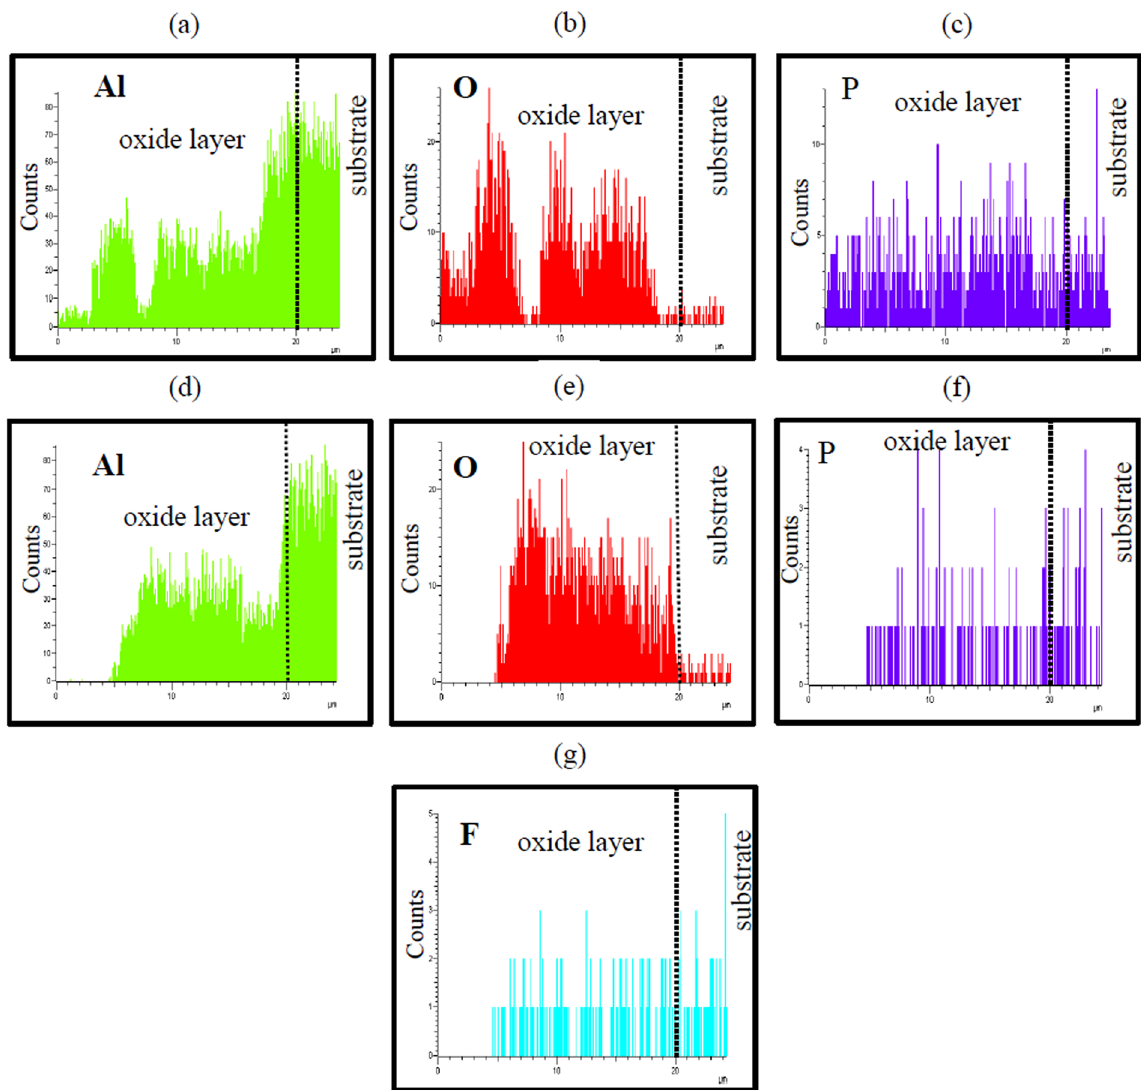
Figure 3. EDS line scan of the cross-section of the coatings formed on an Al-Mg-Si alloy at 125 mA/cm 2 in electrolyte containing no Na 3 AlF 6 ( a – c ) and 3 g/L Na 3 AlF 6 ( d – g